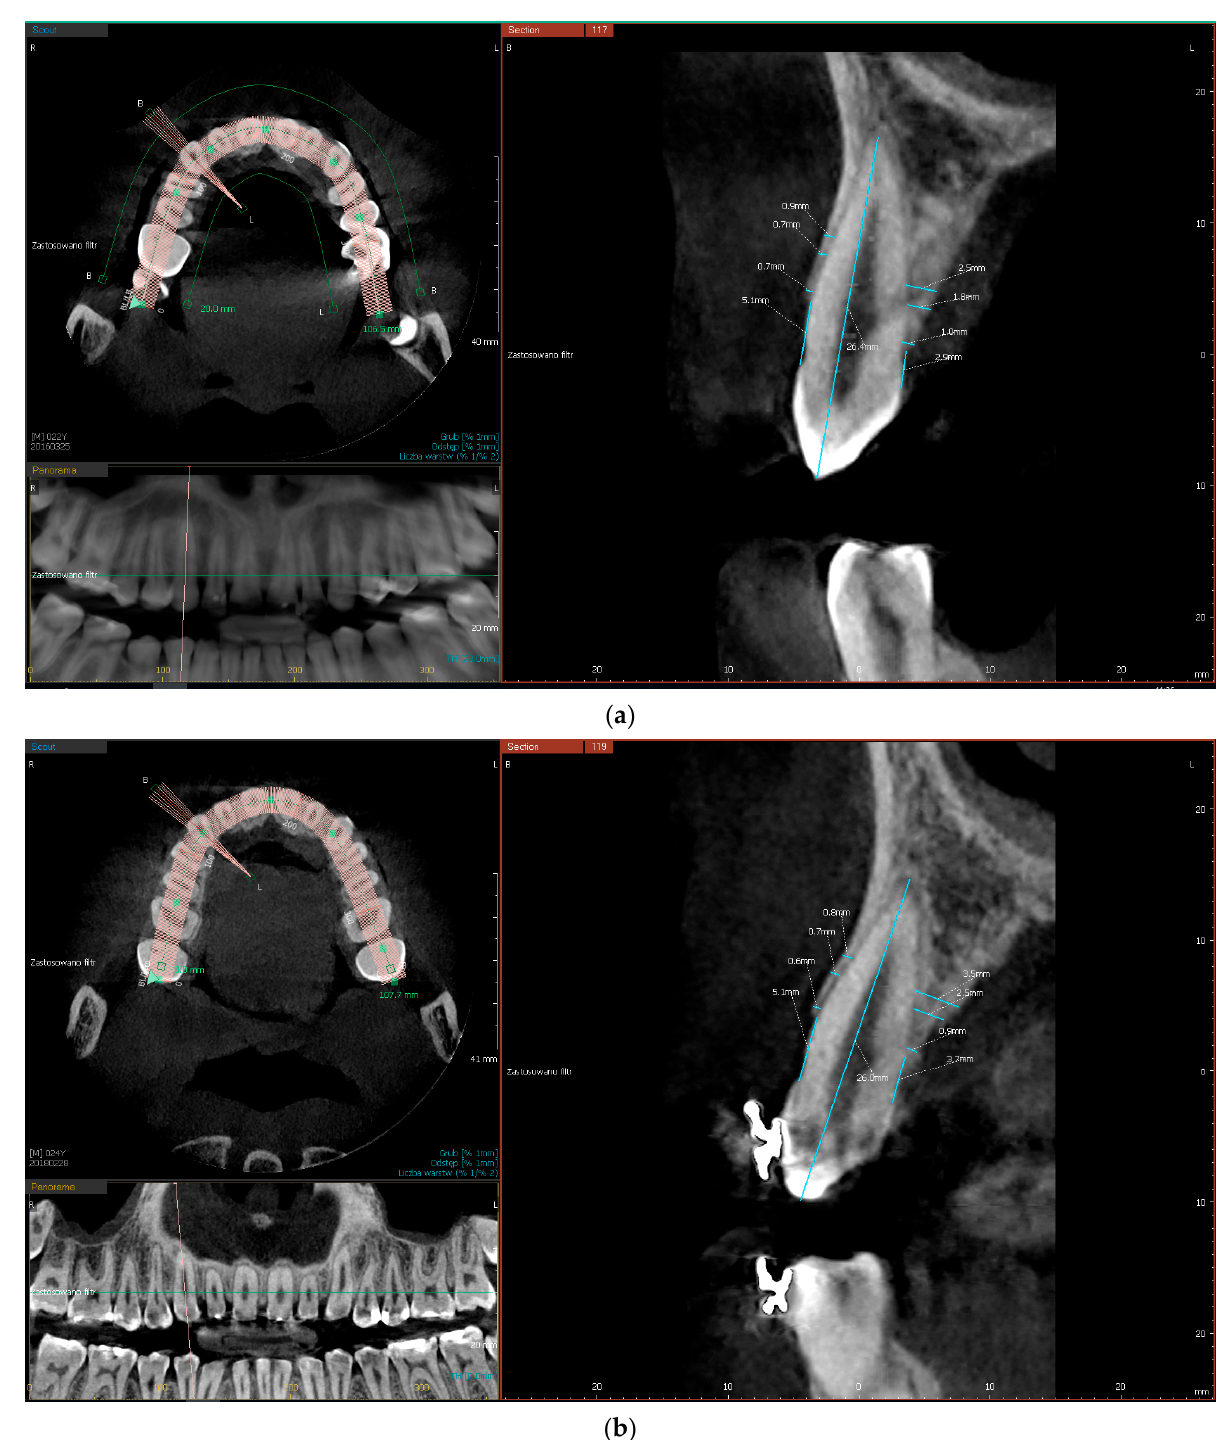
Figure 1. ( a ) CBCT scan of tooth No. 13 taken before treatment. CEJ-B = 5.1 mm, CEJ-P = 2.9, buccal plate thickness 0.5 mm = 0.7 mm, buccal plate thickness 3.5 mm = 0.7 mm, buccal plate thickness 5 mm = 0.9 mm 2.9 mm, palatal plate thickness 0.5 mm = 1 mm, palatal plate thickness 3.5 mm = 1.8 mm, palatal plate thickness 5 mm = 2.5 mm. ( b ) CBCT scan of tooth No. 13 taken after treatment. CEJ-B = 5.1 mm, CEJ-P = 3.7 mm, buccal plate thickness 0.5 mm = 0.6 mm, buccal plate thickness 3.5 mm = 0.7 mm, buccal plate thickness 5 mm = 0.8 mm, palatal plate thickness 0.5 mm = 0.9 mm, palatal plate thickness 3.5 mm = 2.5 mm, palatal plate thickness 5 mm = 3.5 mm.